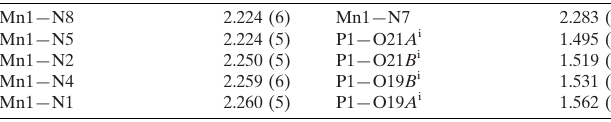
Data collection Bruker APEXII CCD diffractometer